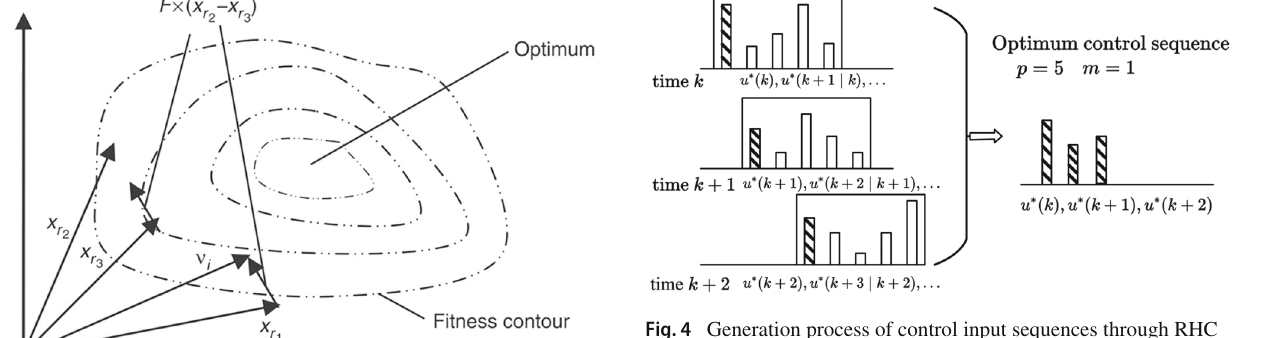
Fig. 4 Generation process of control input sequences through